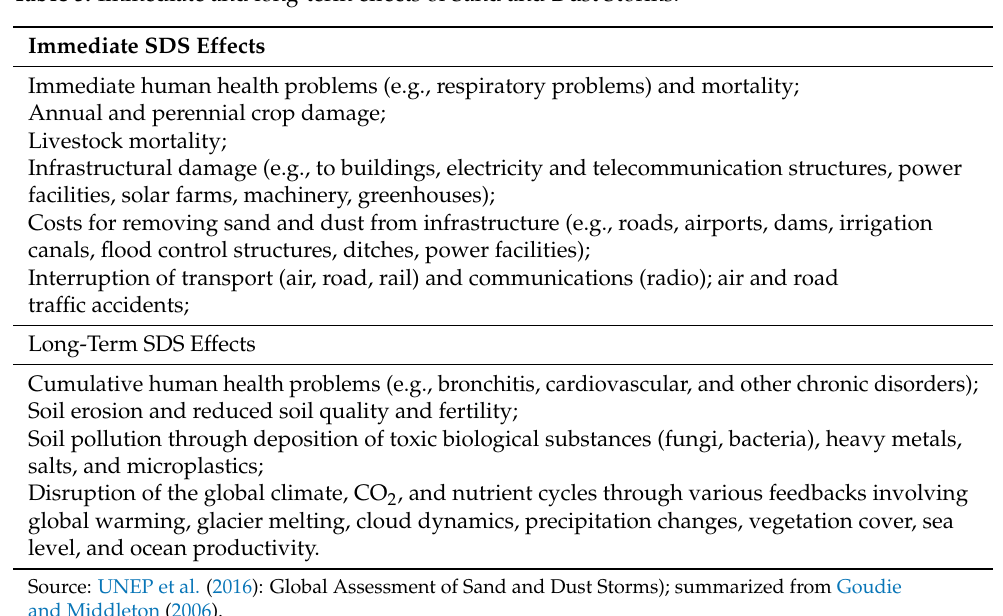
Table 5. Immediate and long-term effects of Sand and Dust Storms.